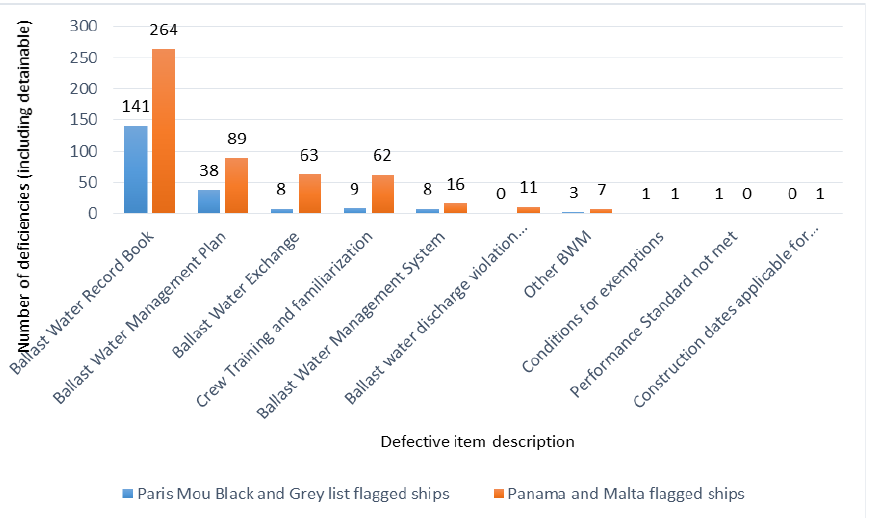
Figure A11. Comparing BWM deficiencies identified by the Paris MoU inspection regime from January 2019 to June 2022 by Paris MoU Black and Grey List flagged ships and Panama and Malta flagged ships.